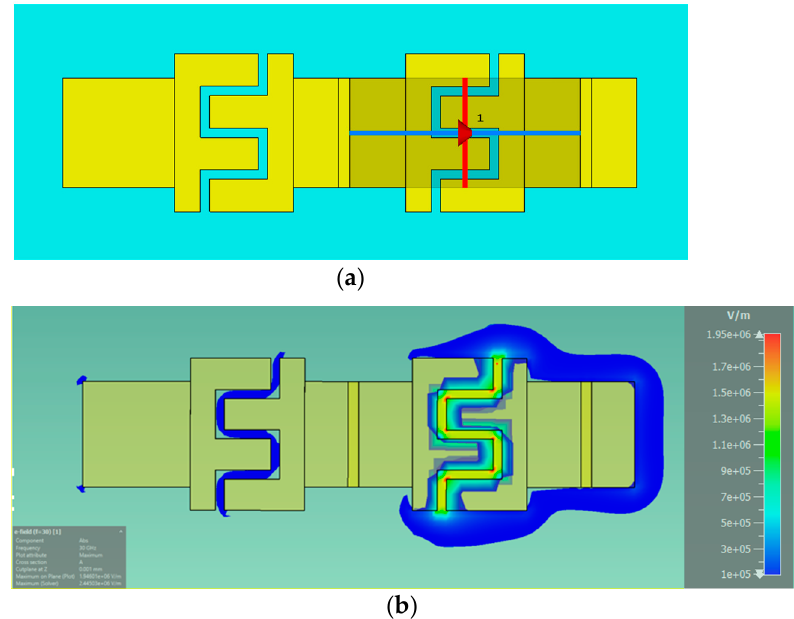
Figure 5. IDC topology used for the electromagnetic simulation, showing the position of the excitation discrete port ( a ) and amplitude of the electric field distribution in the device at 30 GHz ( b ).